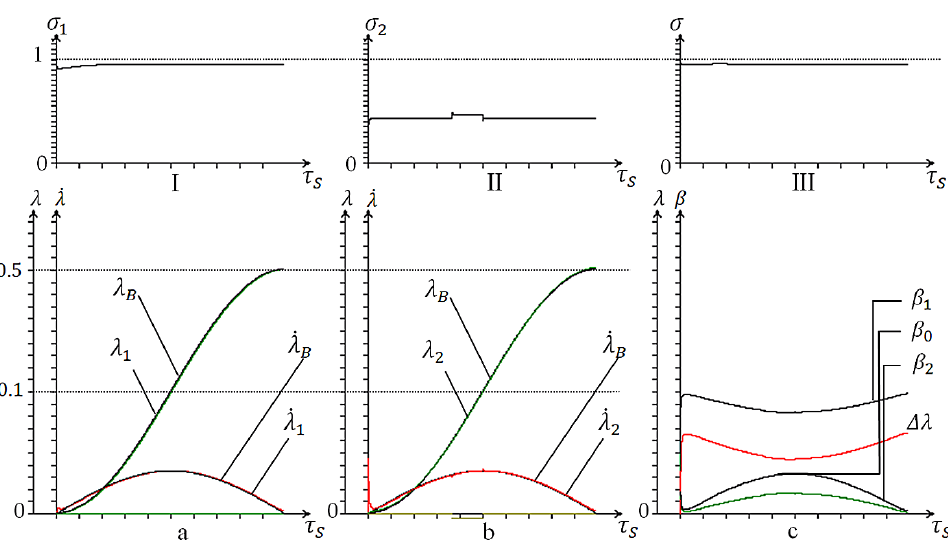
Figure 11. Estimated dynamic characteristics of the solution